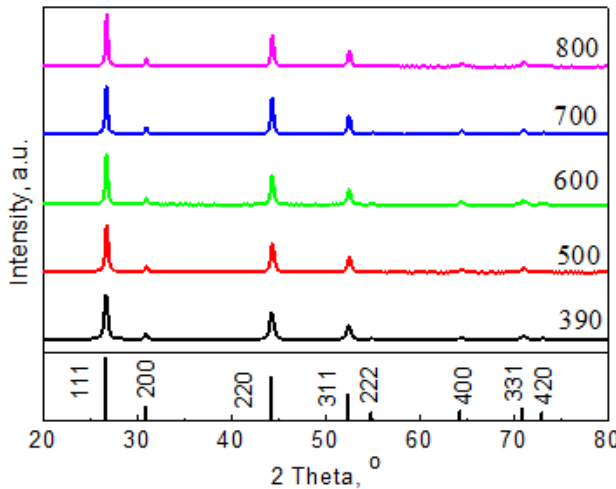
Figure 4. The X-ray patterns for SrF 2 @C catalysts with calcination at different temperatures and the standard profile of SrF 2 (PDF #88-2294).